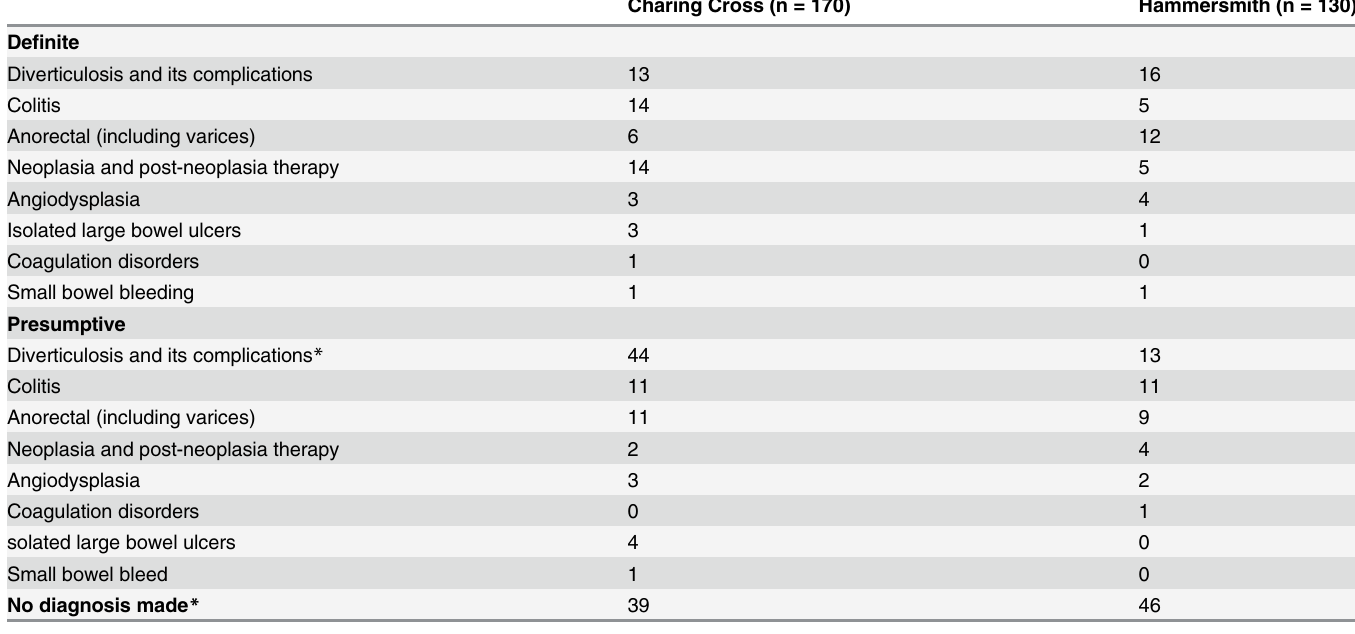
Table 3. Final Diagnoses in